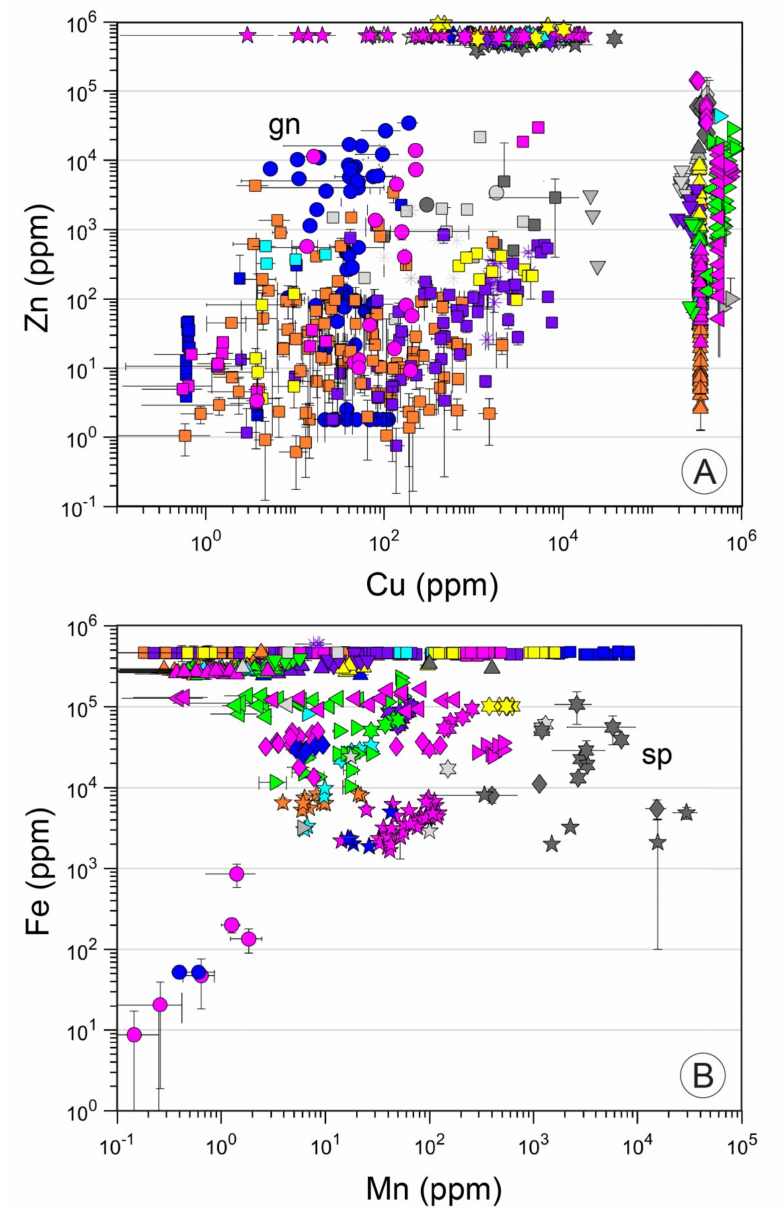
Figure 4. Logarithmic plots displaying a comparison of trace element concentrations (ppm) of ( A ) Cu versus Zn ( B ) Mn versus Fe in sulfide minerals from all hydrothermal vent sites investigated during this study. Abbreviations of minerals used in this figure include sp ( sphalerite ) and gn ( galena ). Shape denotes the type of mineral where squares: pyrite/marcasite, asterisks: pyrrhotite, triangles: Cu phases including downward-pointing triangle: isocubanite, upward-pointing triangle: chalcopyrite, right-pointing triangle: covellite/digenite/chalcocite, left-pointing triangle: bornite, diamond: tennantite-tetrahedrite, five-pointed star: Fe-poor sphalerite, six-pointed star: Fe-rich sphalerite, circles: galena. Colour dictates the tectonic setting where green: ultramafic-hosted MOR (Logatchev), orange: mature MOR (TAG), purple: high temperature MOR (Turtle Pits), cyan: immature MOR (SEPR), yellow: hot spot MOR (AS), magenta: back-arc basin (PM), blue: volcanic arc (PVC). Shown for comparison are data from the literature in grey-scale outlined in Table S8 (light grey: MOR, middle grey: ultramafic MOR and dark grey: